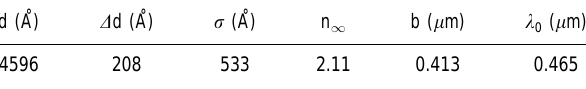
TABLE I Results Obtained from the Optical Interference Method.